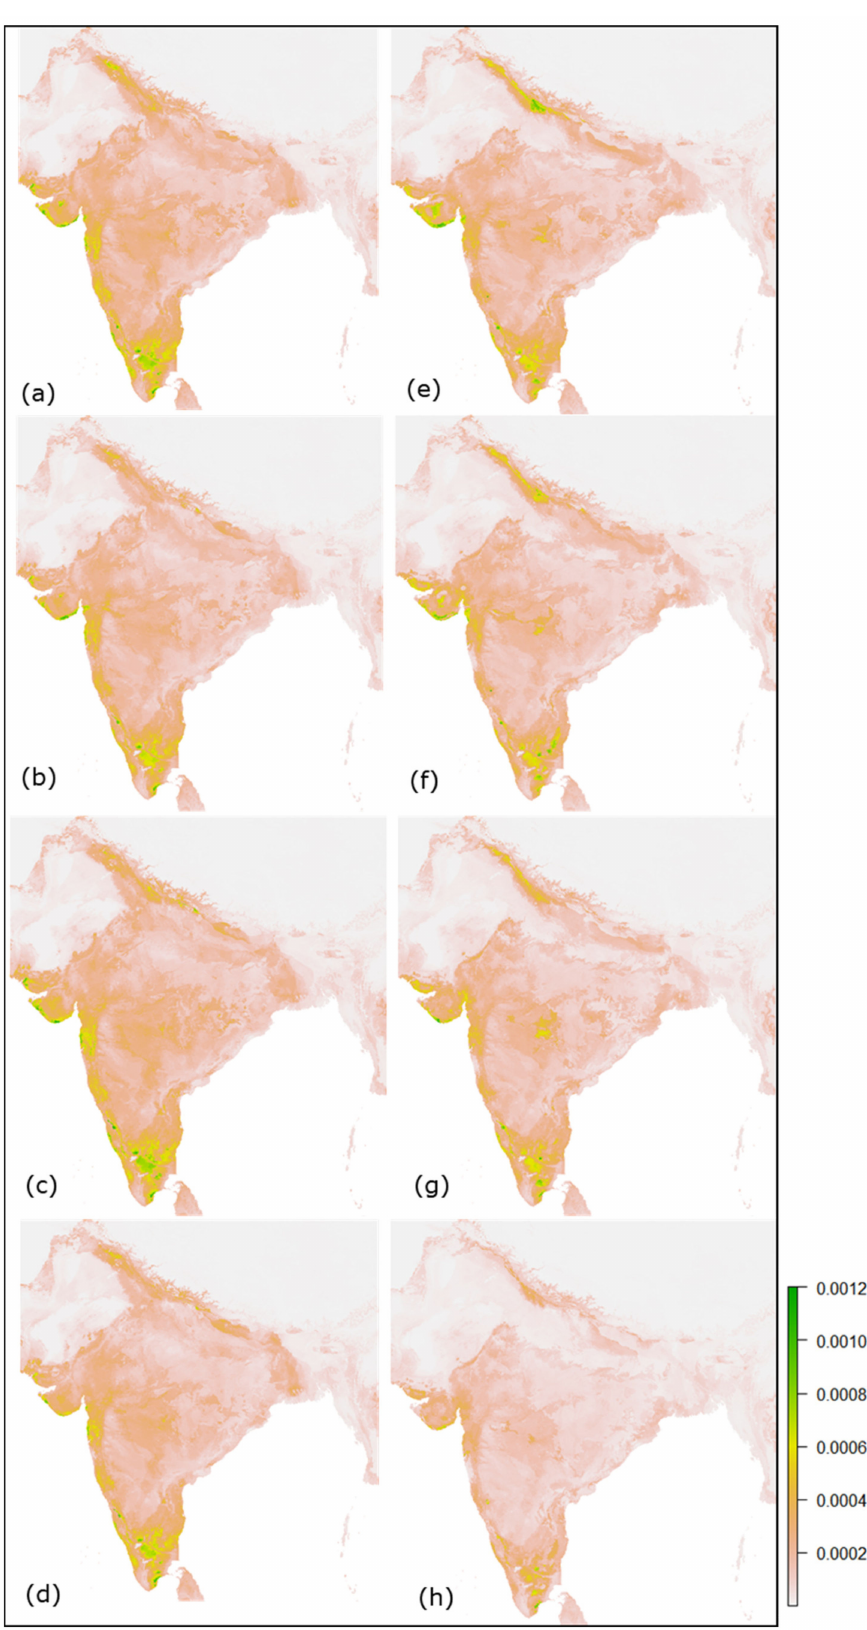
Figure 9. Predicted future habitat suitability maps of the Jacobin cuckoo during June–September of India for the 2030 SSPs 2.6, 4.5, 7.0 and 8.5 ( a – d ) and 2050 SSPs 2.6, 4.5, 7.0 and 8.5 ( e – h